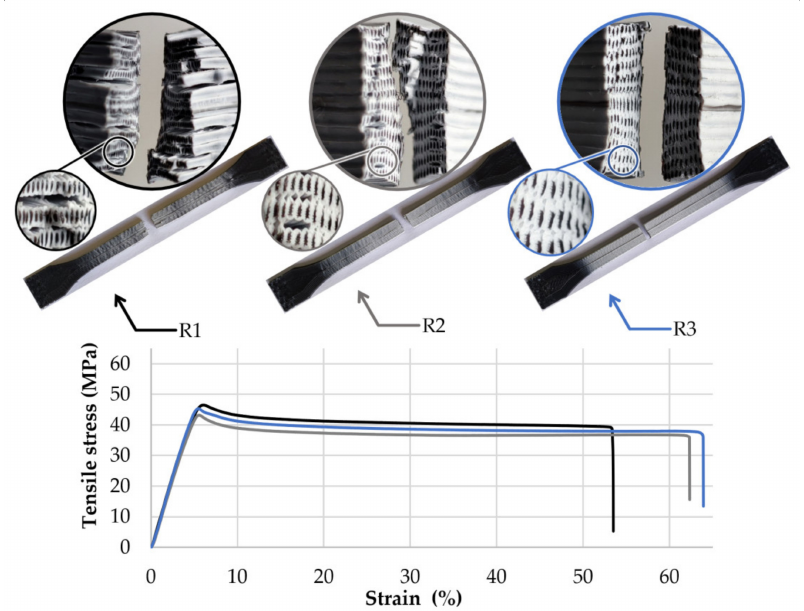
Figure 4. Tensile stress-strain curves, breaking behaviour, and layer structure of the 50PC-50ABS 3D printed filament specimens.